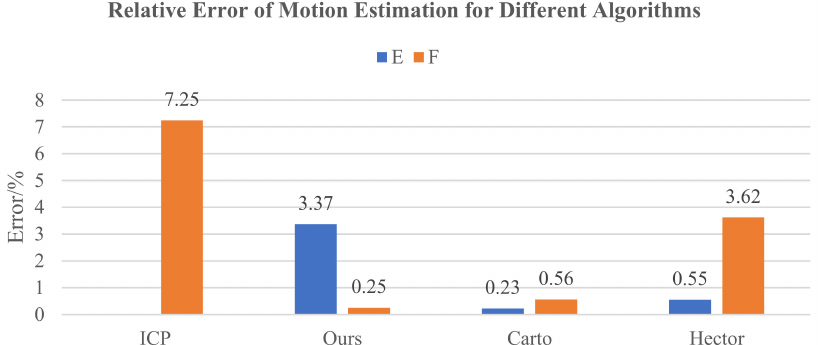
Chart 2. Relative errors of motion estimation drift for different algorithms. E and F are different open-access datasets.